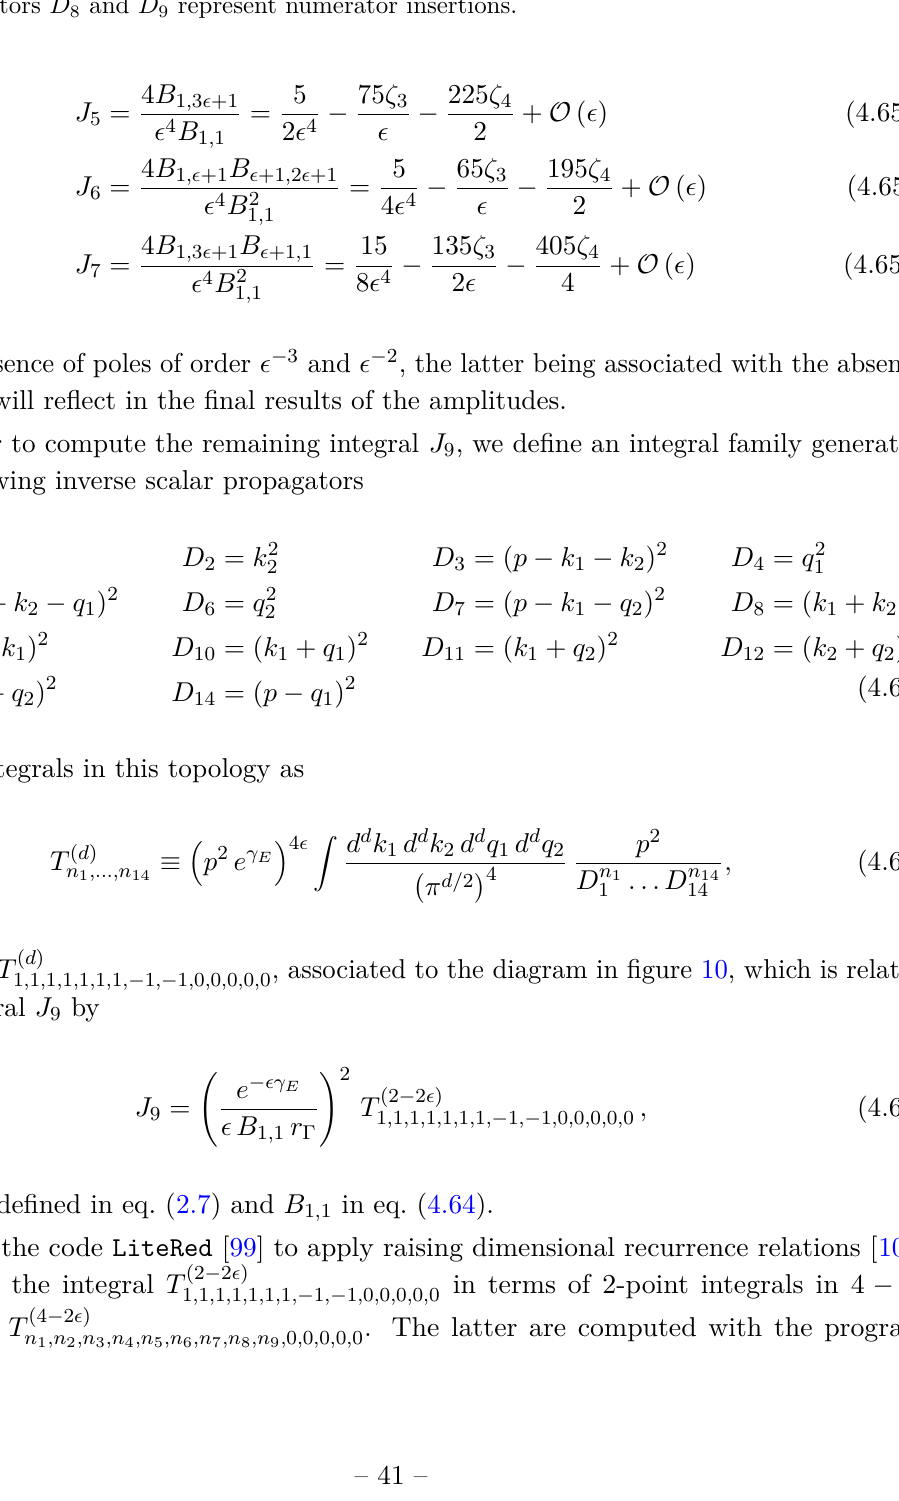
which is related to the required integral J Figure 10. The integral T (2 − 2 (cid:15) ) 1 , 1 , 1 , 1 , 1 , 1 , 1 , − 1 , − 1 , 0 , 0 , 0 , 0 , 0 through eq. (4.68). Arrows on the scalar propagators are added to keep track of the momentum flow. The factors D and D represent numerator 8 9